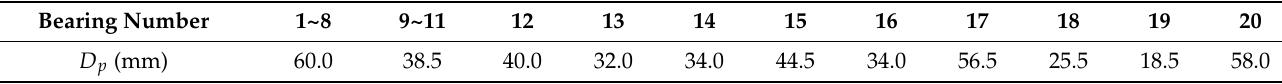
Figure 4. Bearing installations in the transmission model. Table 4. Pitch diameters of bearing 1 to 20.